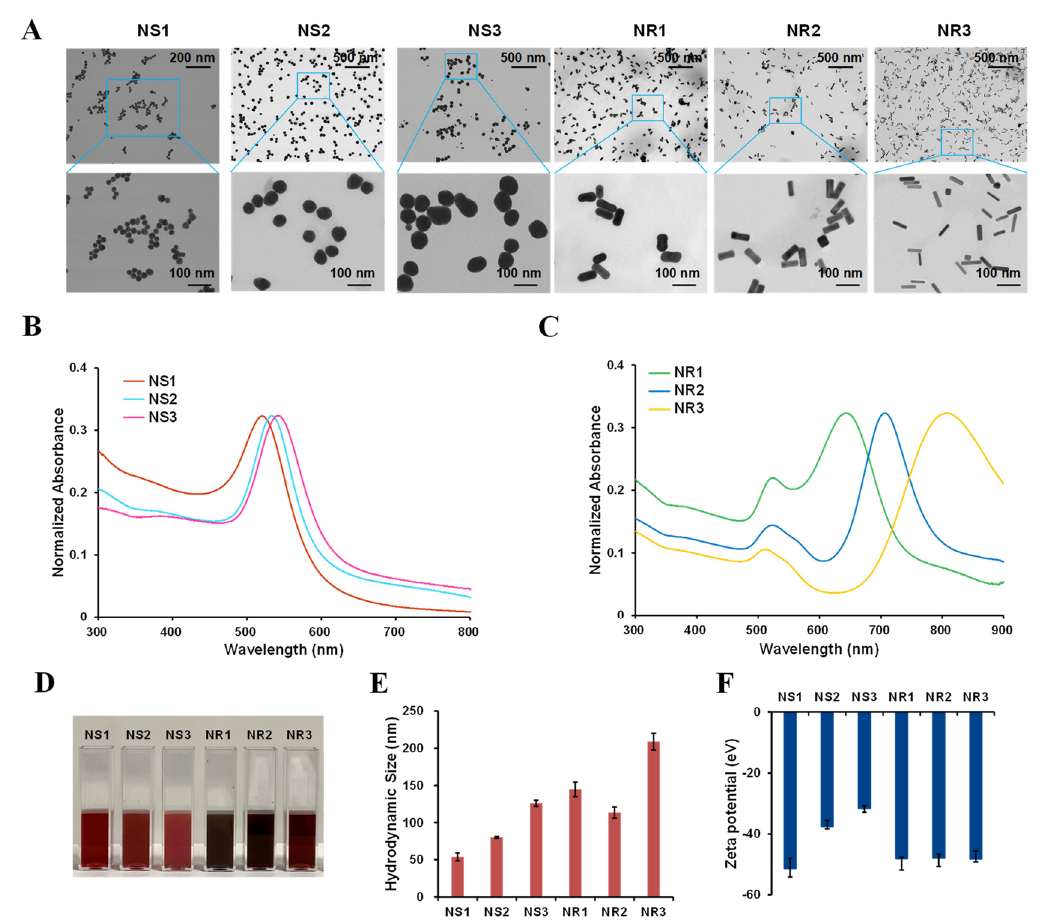
Figure 2. Characterization of synthesized Au NMs. ( A ) TEM images; ( B ) UV − Vis − NIR spectrum of Au NSs; ( C ) UV − Vis − NIR spectrum of Au NRs; ( D ) photographs of aqueous solution of Au NMs; ( E ) hydrodynamic size; ( F ) zeta potential.